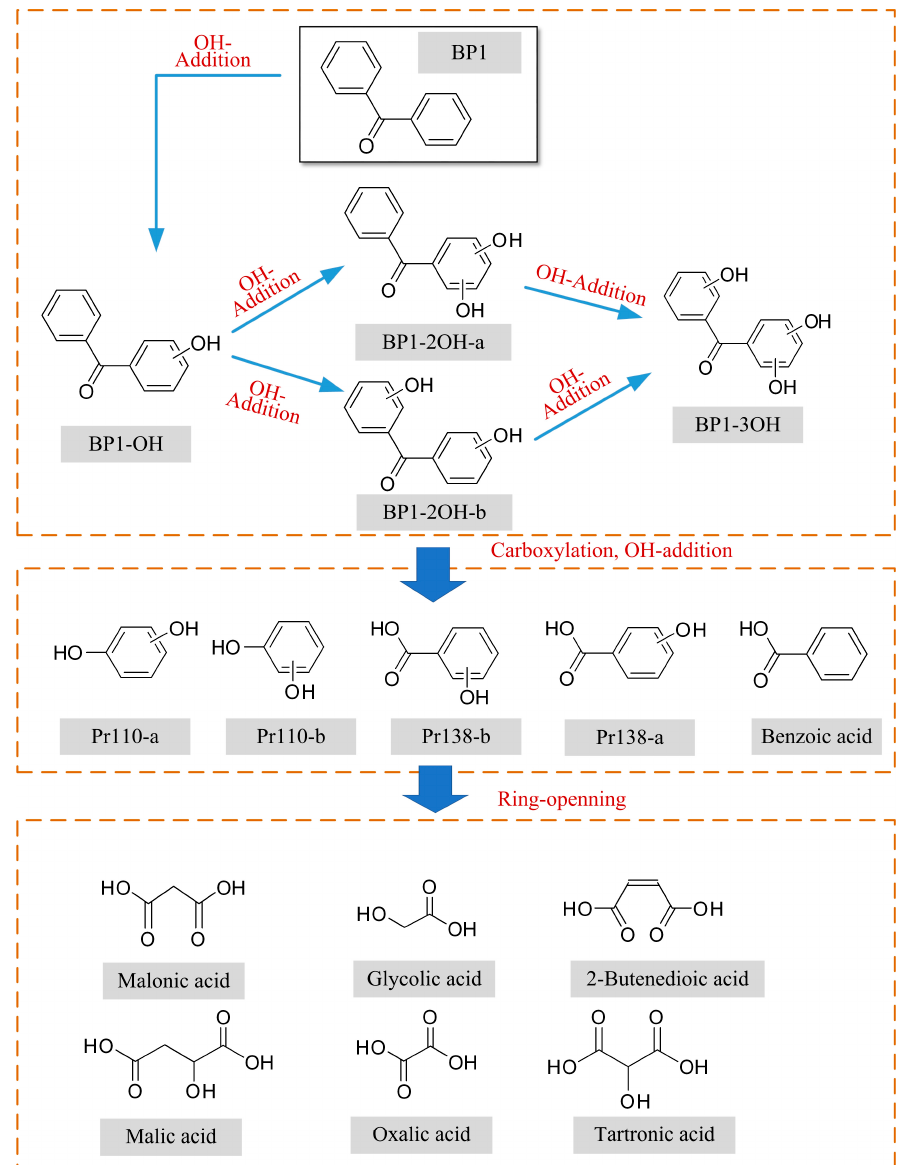
Figure 8. Proposed pathway of the BP degradation by the UV/H 2 O 2 process.